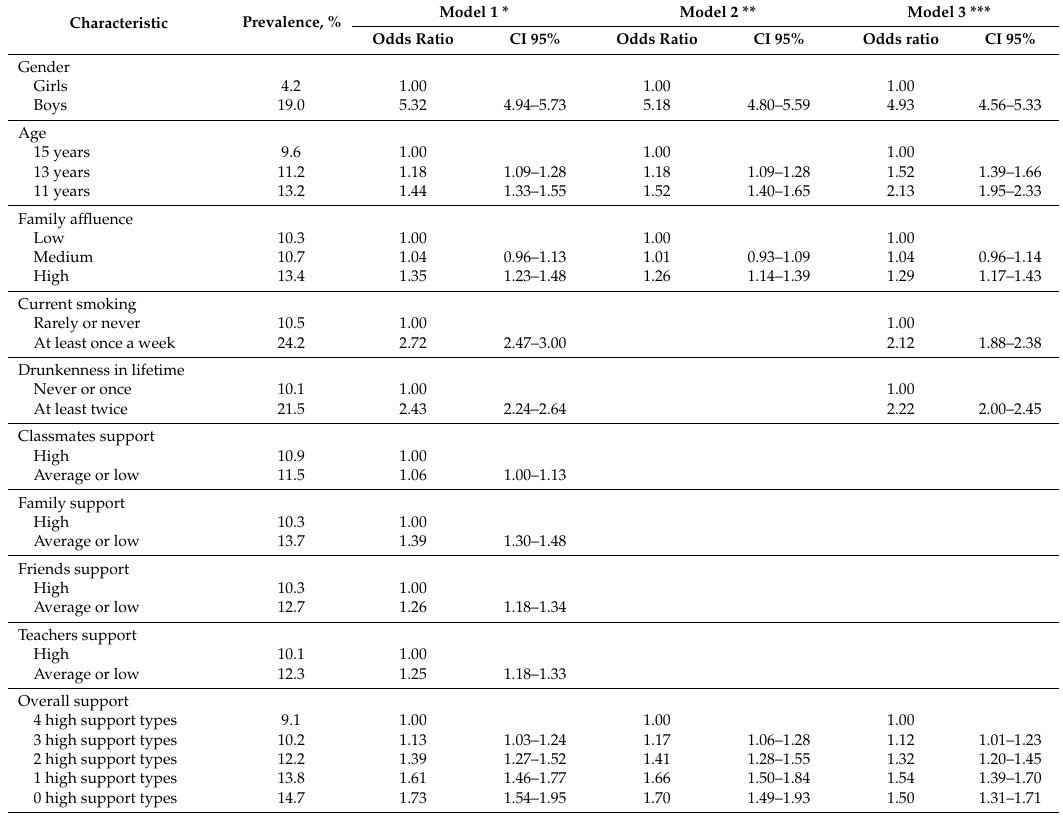
Table 6. Fighting and associated factors in all countries: logistic